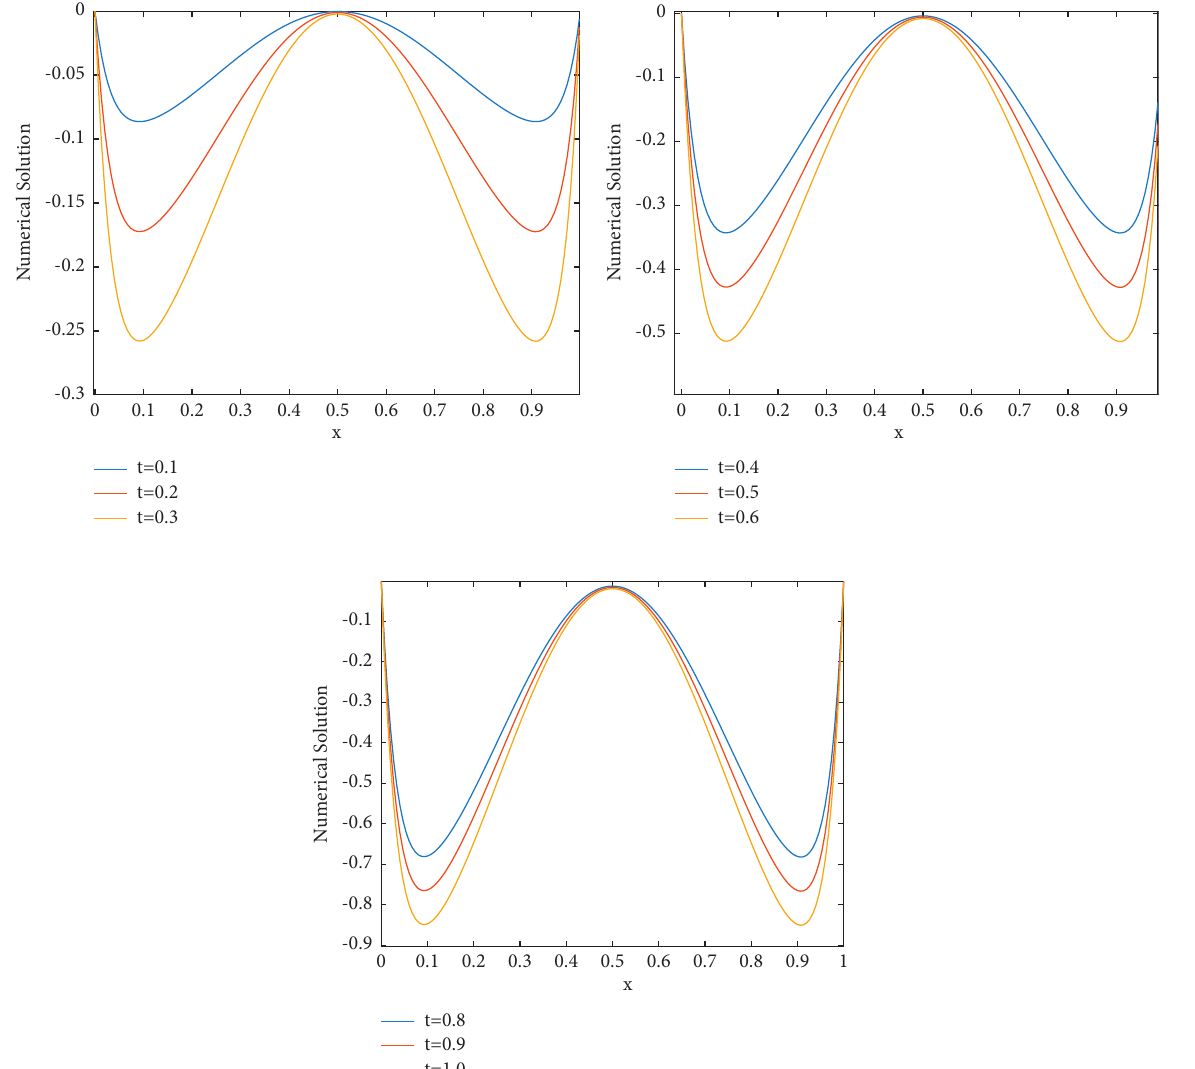
Figure 2: Solution behavior of the mode at different time with parameter ε � 2 − 10 and M �